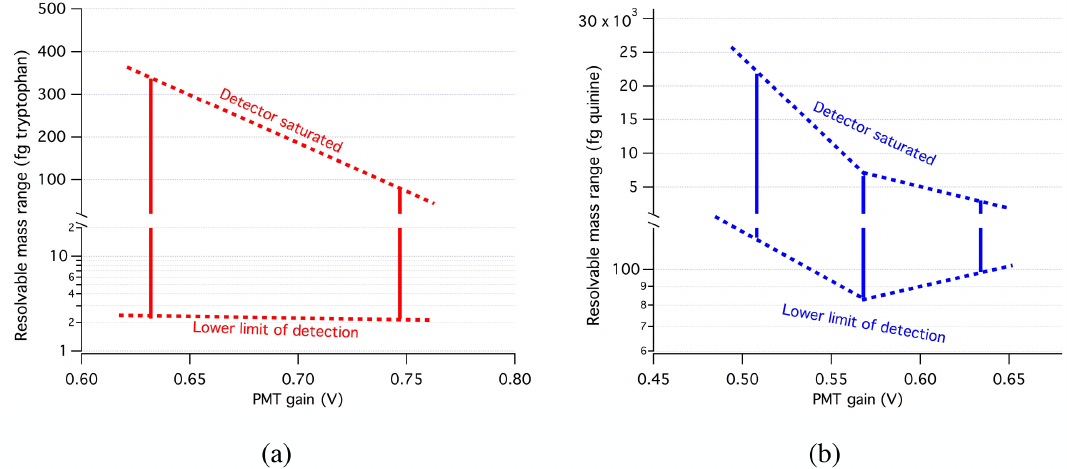
Figure 11. Detection bands showing the lower limit of detection and the fluorophore mass that saturates the detector as a function of detector gain voltage for (a) the FL1 channel (tryptophan) and (b) the FL2 channel (quinine). Dotted lines are visual guides showing the range of fluorophore mass that is outside of the detection